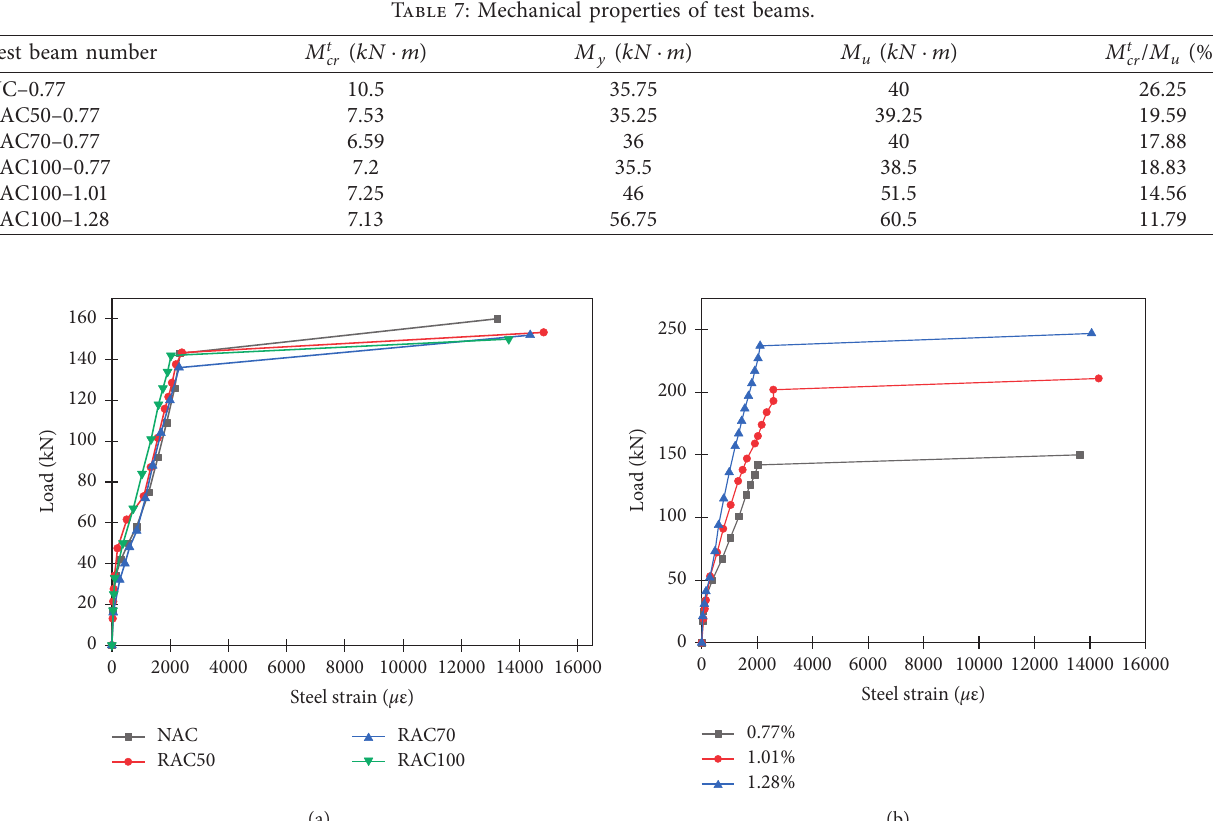
Figure 6: Load VS steel strain curves. (a) Substitution ratio of RCA. (b) Reinforcement ratio of tensile